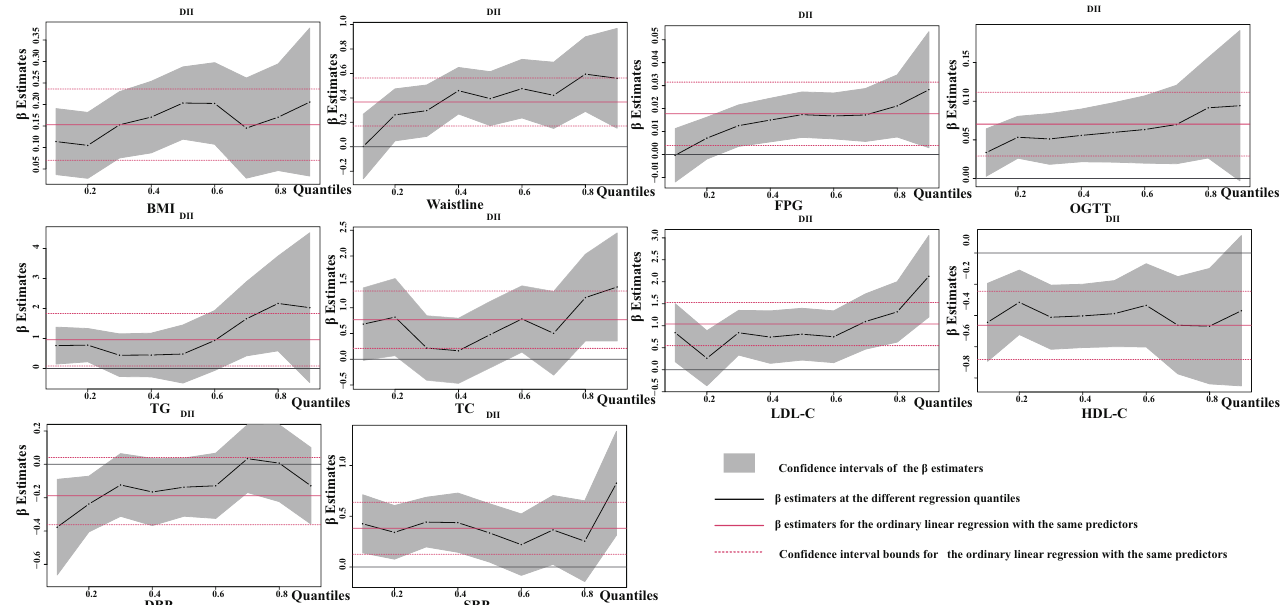
Figure 7. Quantile regression estimation coefficient plot of DII level versus biochemical index of MetS. Adjusted for confounding factors such as age, gender, race, education, poverty–income ratio, smoking, alcohol consumption, and sedentary